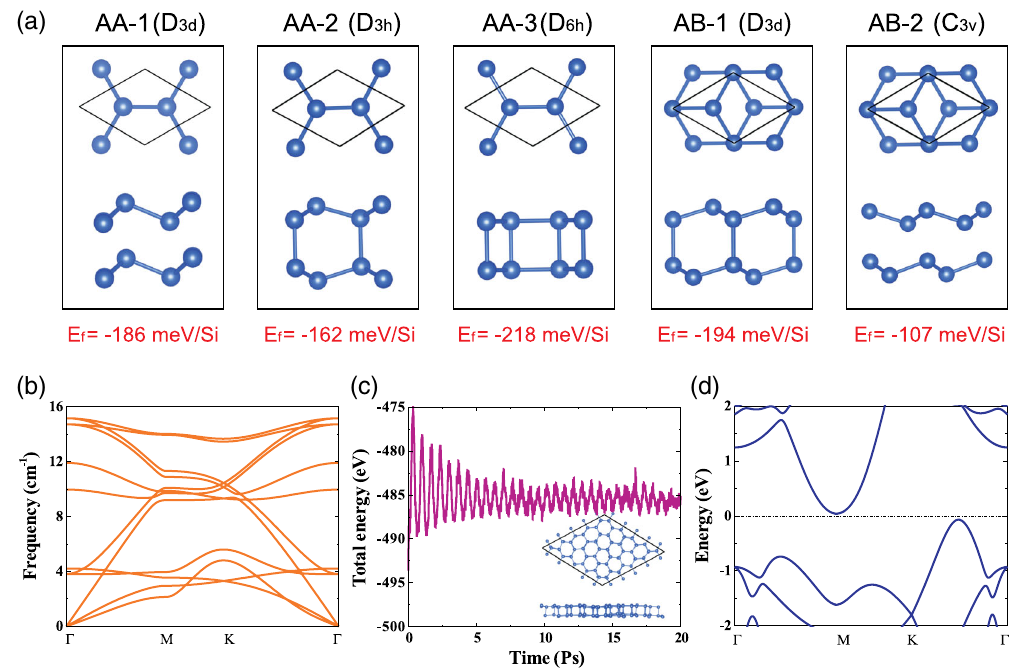
FIG. 1. (a) The structure and symmetry of five BS structures with AA or AB stacking. The formation energy E with respect to single-layer silicene is also plotted. (b) The phonon spectrum of the AA-3 structure. (c) The fluctuation of total energy of (100-atoms/cell) the AA-3 structure as a function of the molecular-dynamic simulation step at 600 K. (d) The calculated band structure of the AA-3